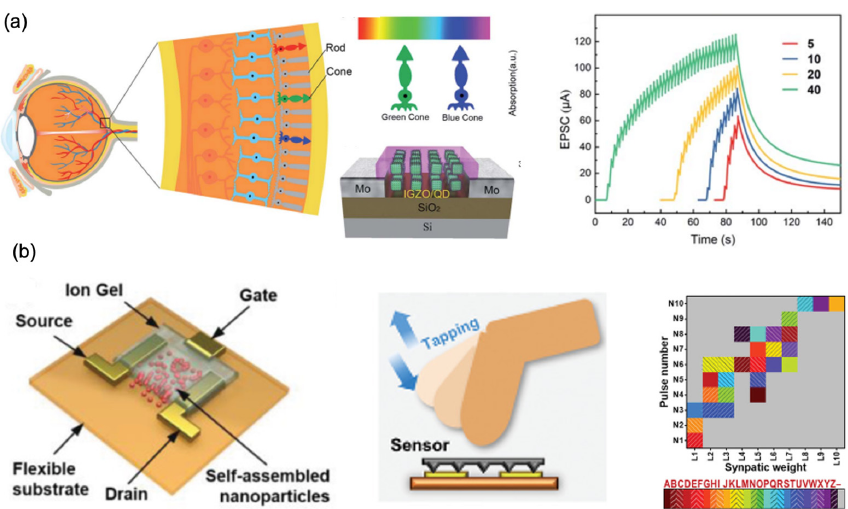
Figure 11. ( a ) The schematic diagram for the human visual system, consisting of rods and three types of cones, red, green, and blue. Learning and memorizing capability of this photonic synaptic device under stimulated light (450 nm) accorded with the various pulse numbers and pulse times [139] Reprinted/adapted with permission from Ref. [139] Xin, 2021. ( b ) The structure of ion-gel-gated synaptic transistor composed of interdigitated electrodes, a self-assembled NP channel, and chitosan- based electrolyte on a polyimide flexible substrate. Recognition of tactile patterns took place by tapping Morse code and the classification of 26 letters on a 10 × 10 mapping [140] Reprinted/adapted with permission from Ref. [140] Jiang,